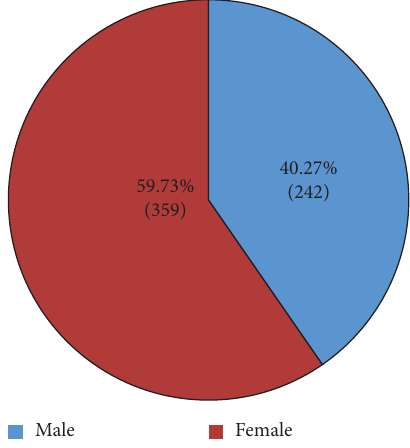
Figure 1: Gender distribution of the